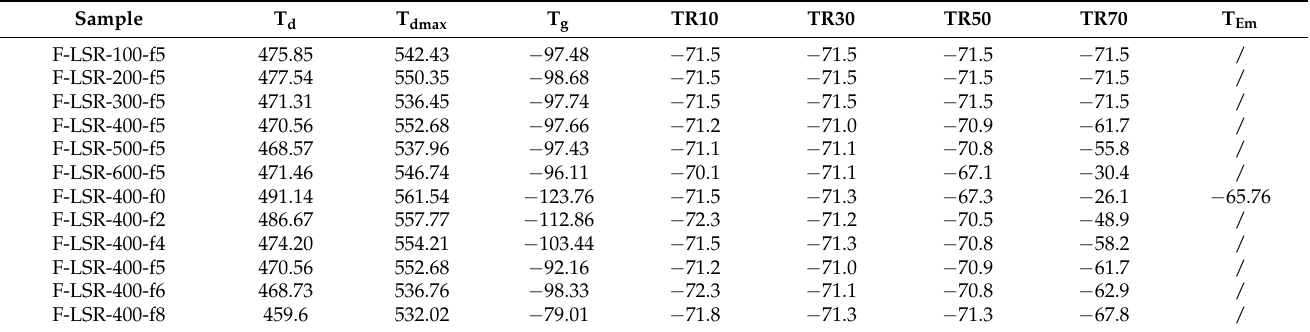
Figure 8. TGA thermogram and derivation of TGA curves of F-LSRs: ( a , b ) with different fluorine ratios and ( c , d ) with different chain lengths. Table 5. Thermal properties of F-LSRs obtained from TGA, DSC, TR-test, and embrittlement